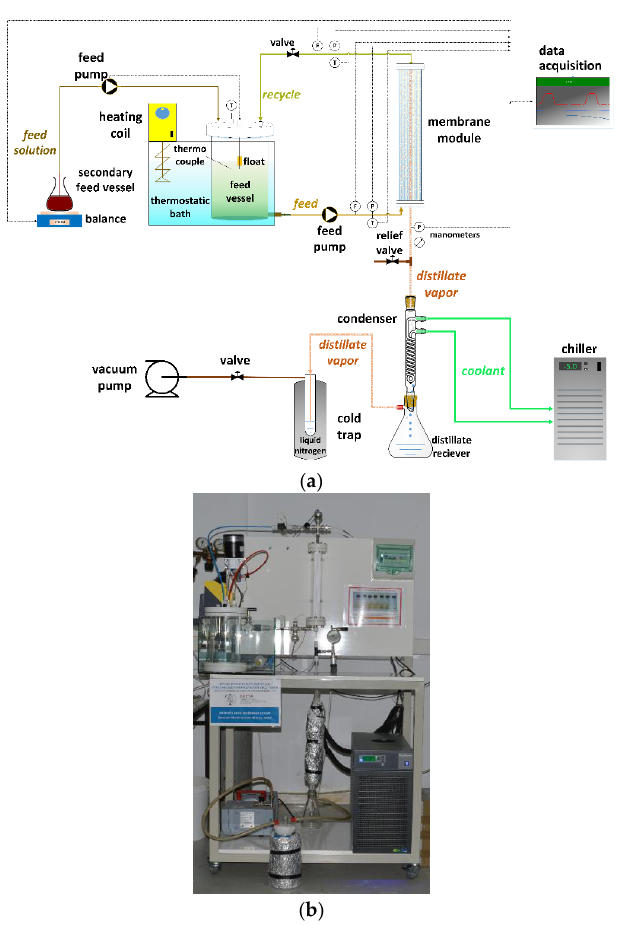
Figure 3. Experimental set-up: ( a ) flow diagram and ( b ) frontal